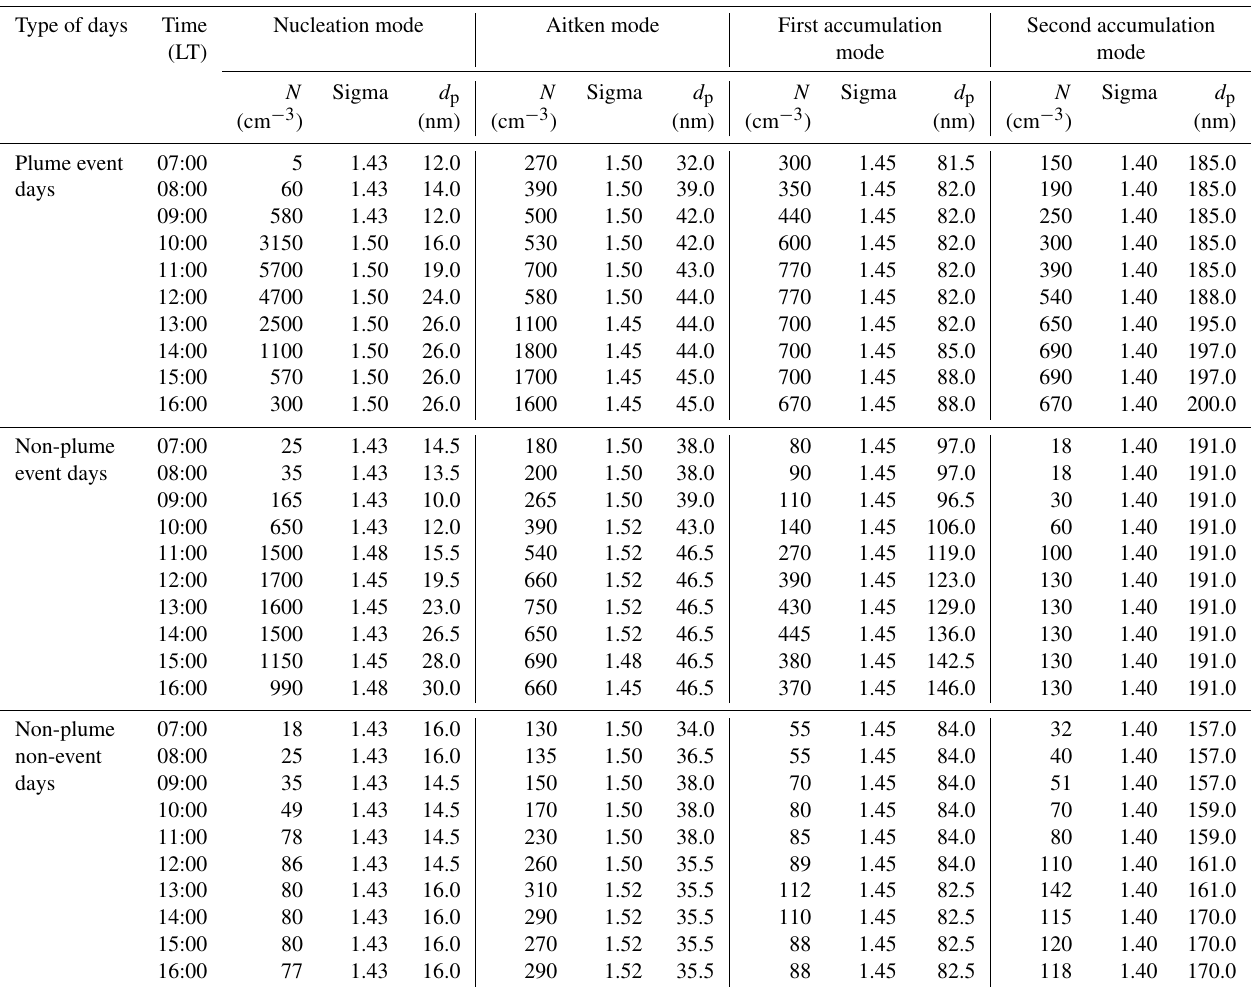
Table A1. Parameters of the Gaussians used to fit the hourly median DMPS size distributions shown in Fig. 6. Type of